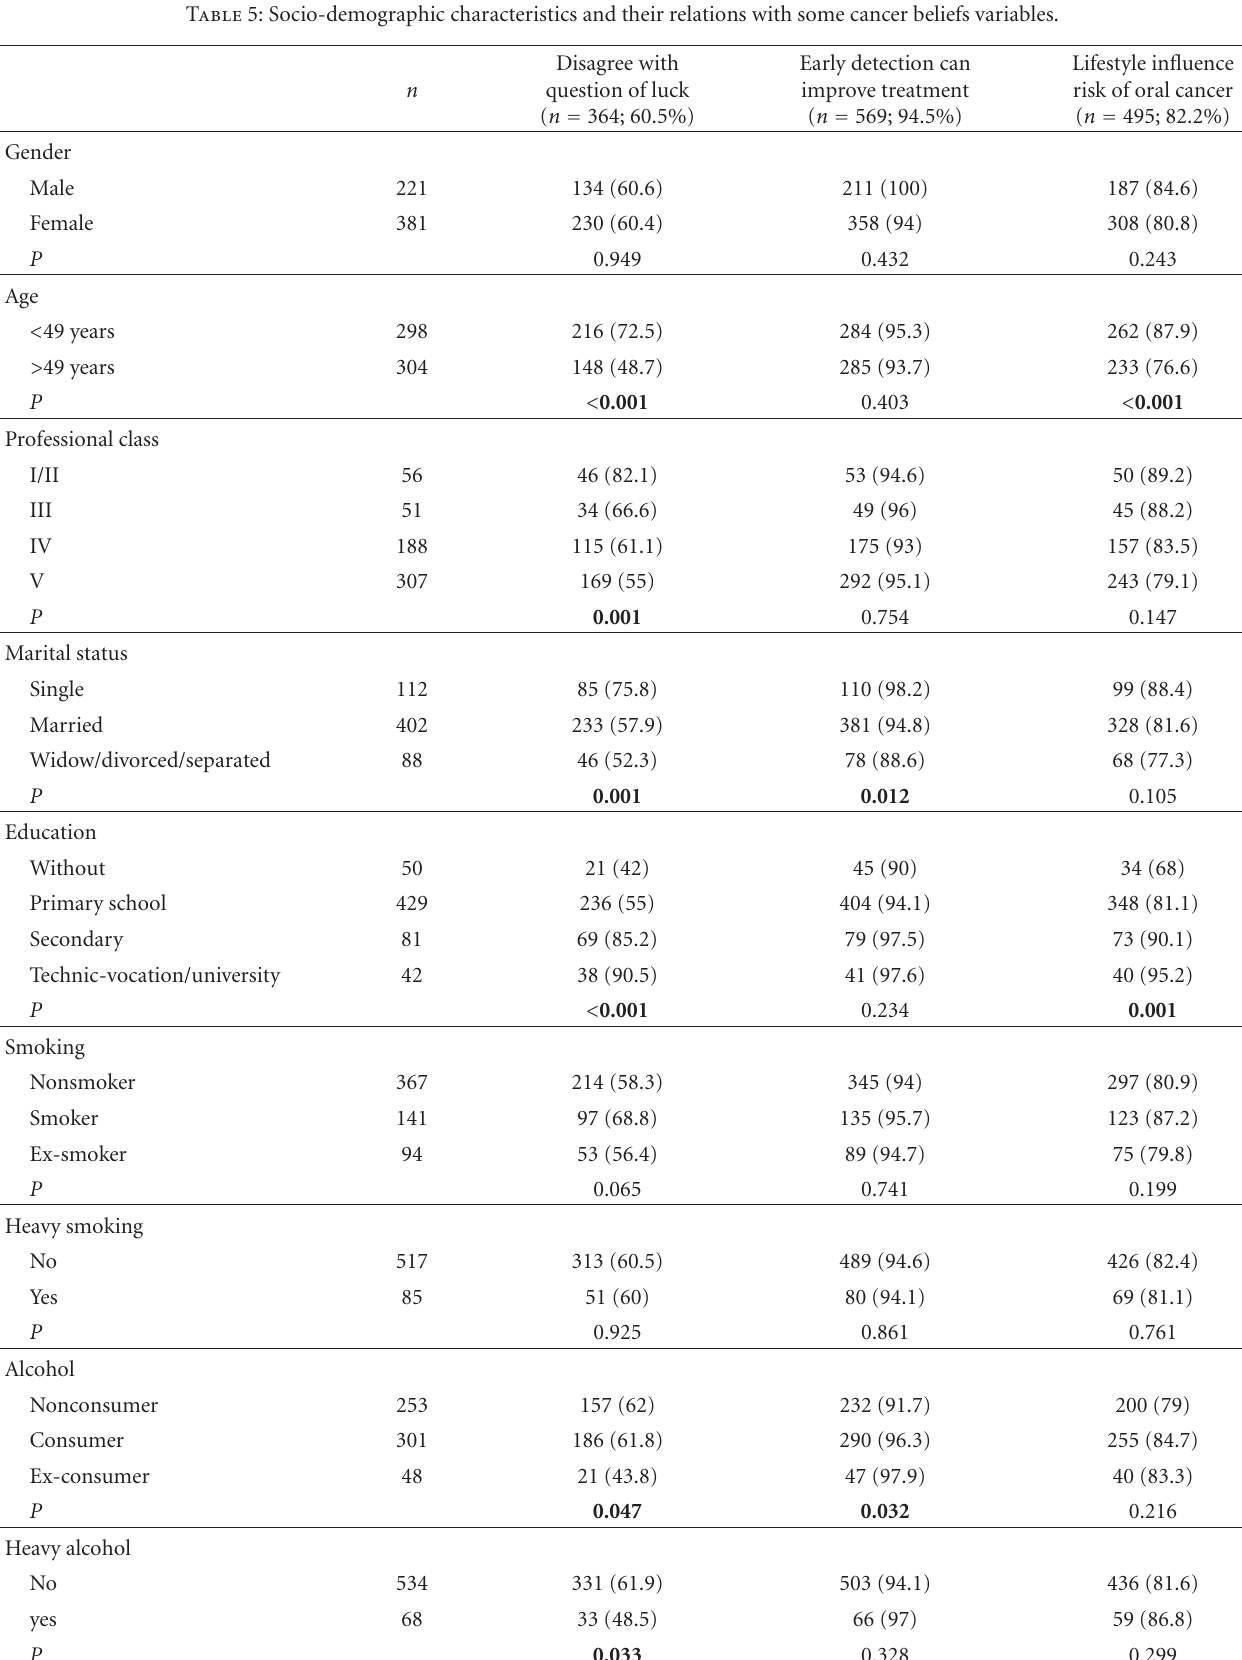
Table 5: Socio-demographic characteristics and their relations with some cancer beliefs